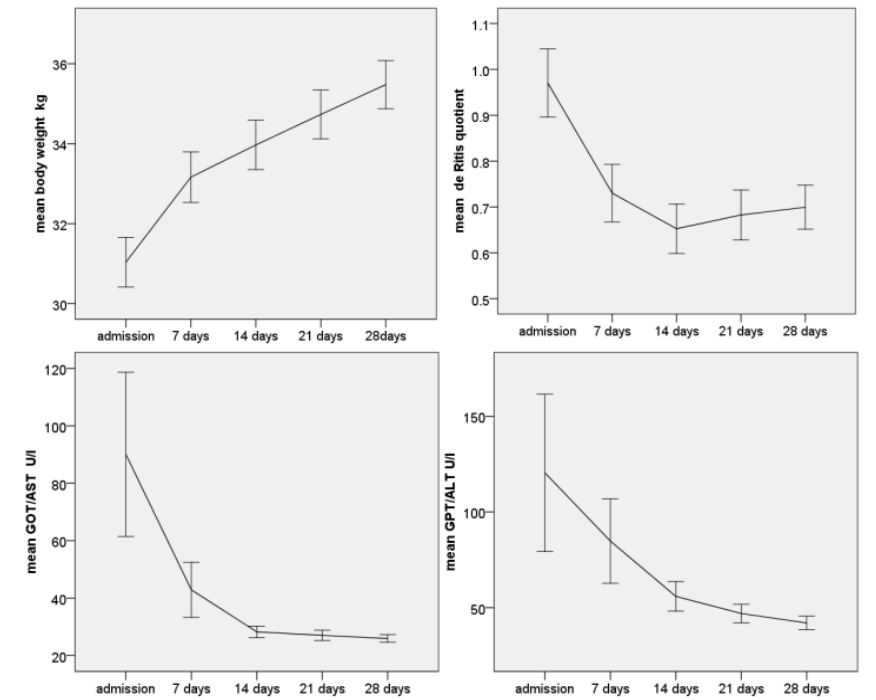
Figure 3. N = 142 Change in body weight in kg (MANOVA p < 0.001, F = 347.0), GOT (MANOVA p < 0.001, F = 17.5), GPT (MANOVA p < 0.001, F = 13.2) and de Ritis quotient (MANOVA p < 0.001, F = 54.9) during the course of refeeding. Error bars represent 95% confidence interval.